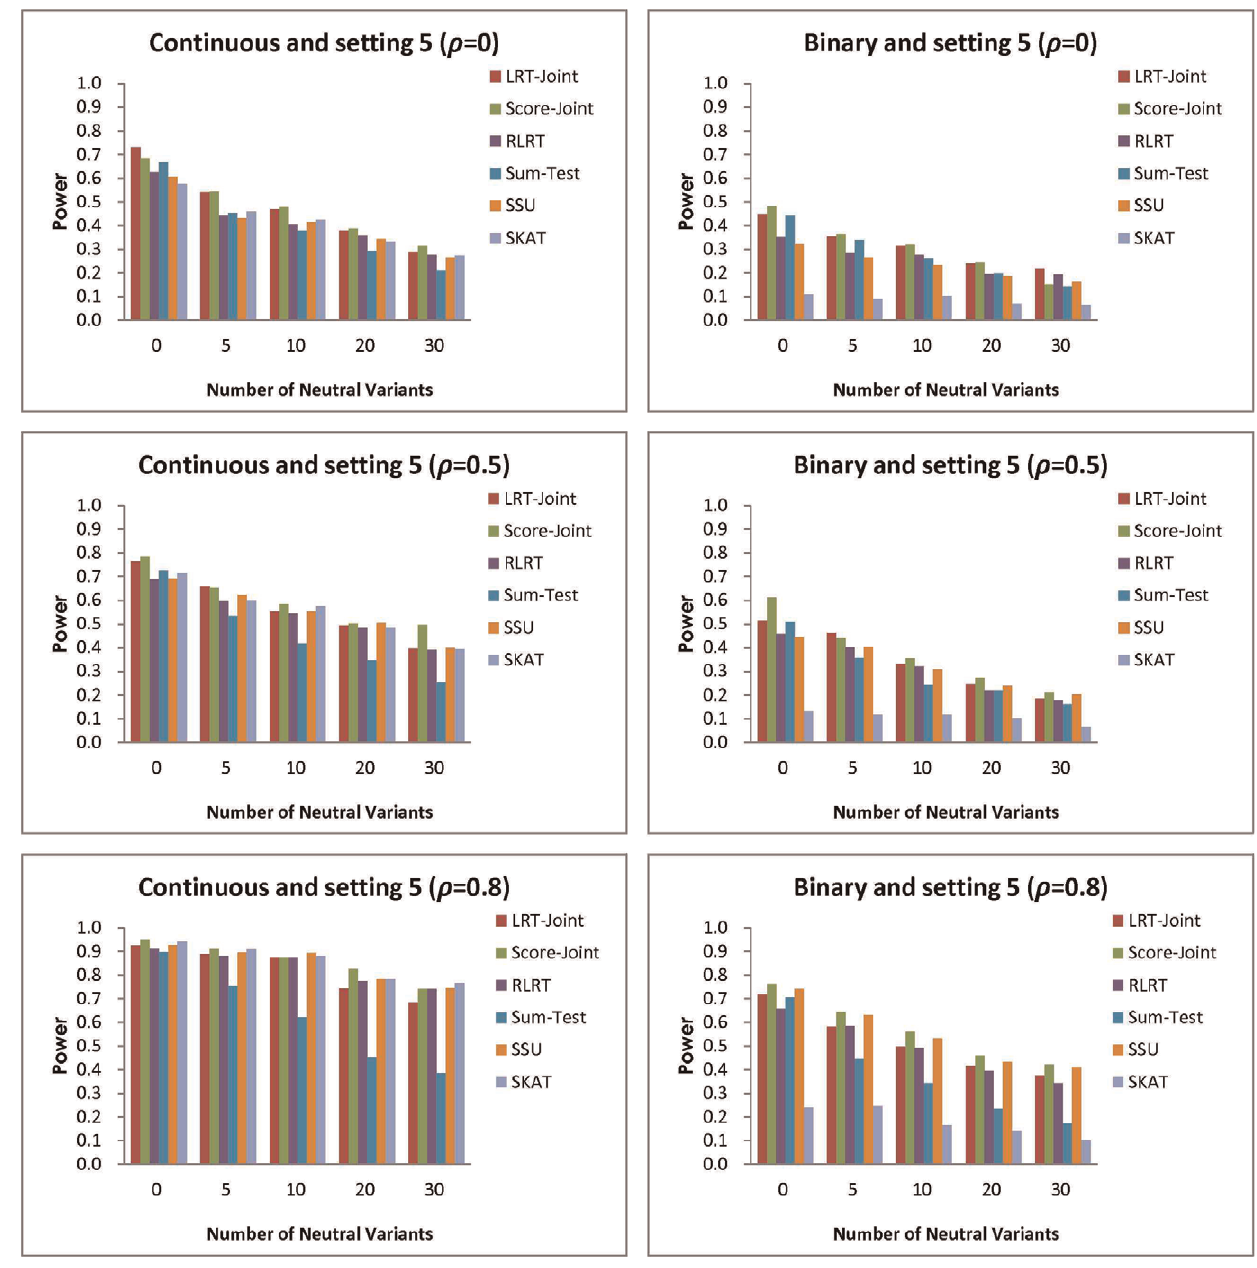
Figure 7. Simulation setting 5: b k ~ ( 0 : 4 , 0 : 4 , 0 : 35 , 0 : 35 , 0 : 3 , 0 : 3 , 0 : 2 , 0 : 1 , { 0 : 1 , { 0 : 2 ) T ( continuous trait ) ; OR ~ ( 2 , 2 , 1 : 8 , 1 : 8 , 1 : 6 , 1 : 6 , 1 : 4 , 1 : 2 , { 1 : 2 , { 1 : 4 ) T ( binary trait ) .